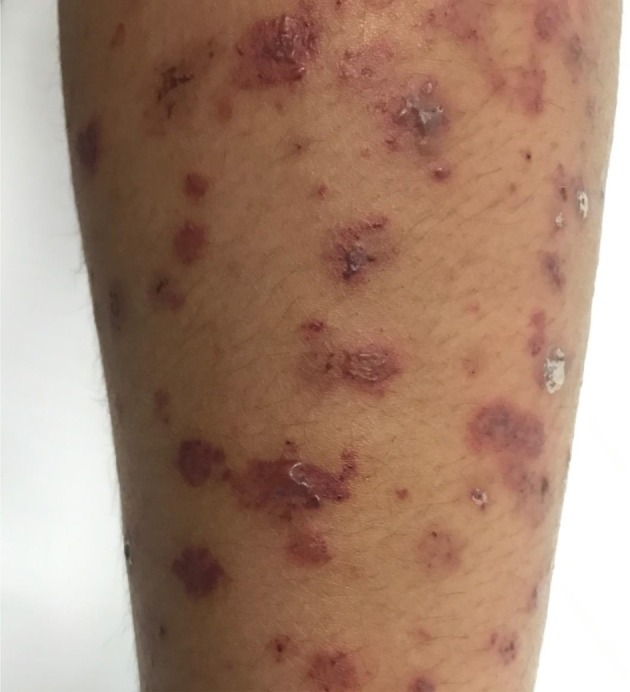
Eight year old diagnosed with GPA with leucocytoclastic vasculitis involving upper and lower limbs.